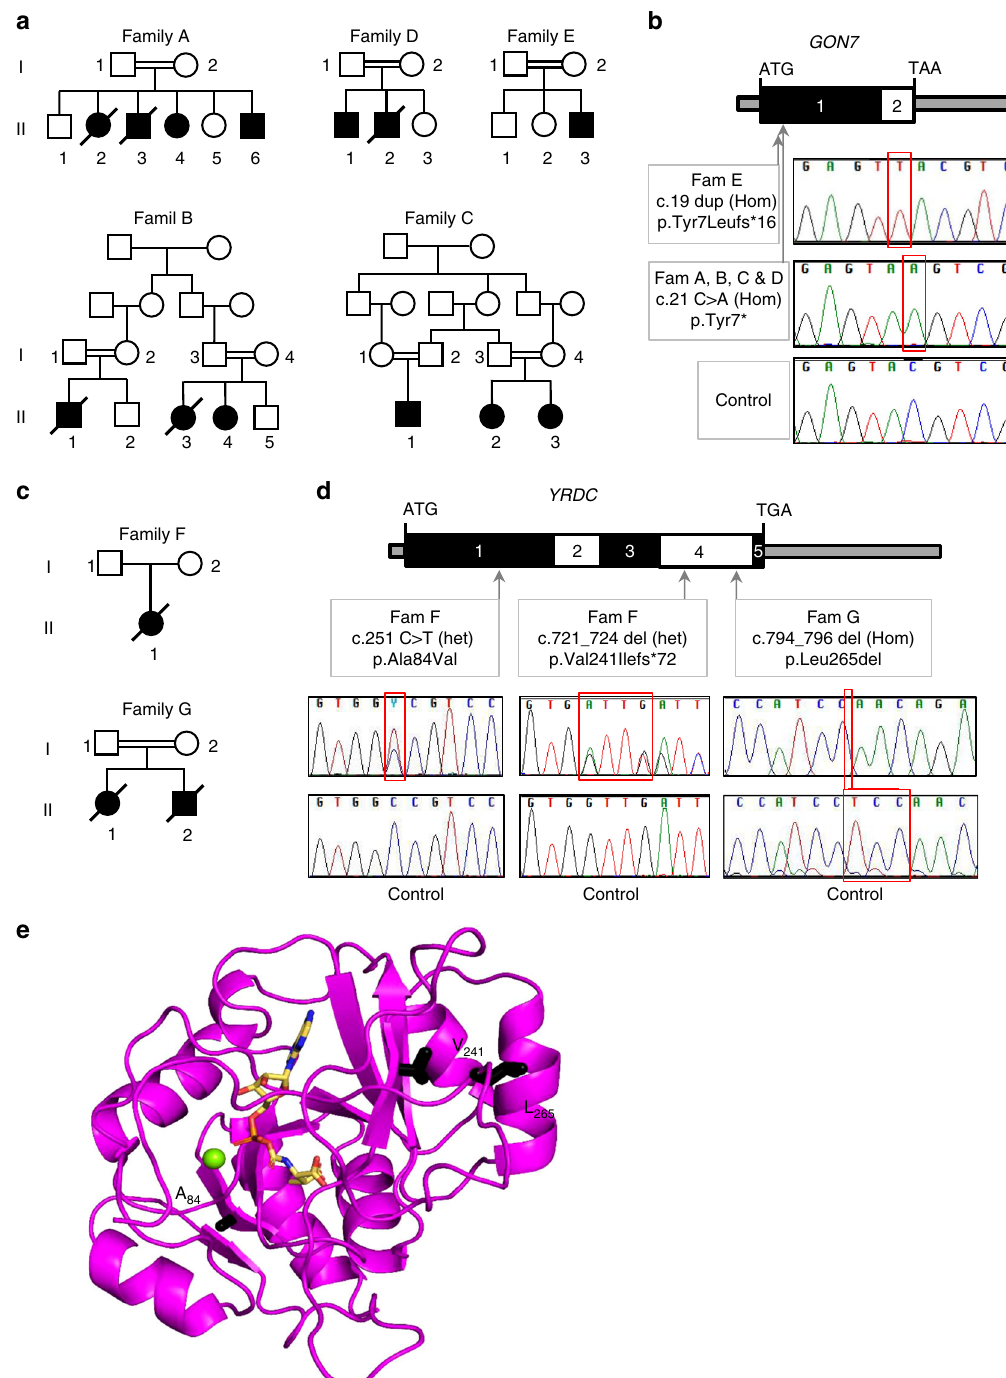
Fig. 1 Identi fi cation of mutations in GON7 and YRDC in patients with Galloway-Mowat syndrome. a , c Pedigrees of families with mutations in GON7 ( a ) and in YRDC ( c ). Affected individuals are in black. b , d Organization of exons of human GON7 and YRDC cDNAs. Positions of start and stop codons are indicated. Arrows indicate positions of the identi fi ed mutations. Lower panels show the sequencing traces for affected individuals with identi fi ed mutated nucleotide indicated with a red square (Hom: homozygous; het, heterozygous). e Representation of a 3D model of human YRDC, bound to the reaction product threonylcarbamoyl-adenylate, in sticks. The model was constructed using the crystal structure of Sulfolobus tokodaii Sua5 (PDB code 4E1B). The side chains of the three mutated residues are in black sticks. The green sphere represents an Mg 2 +